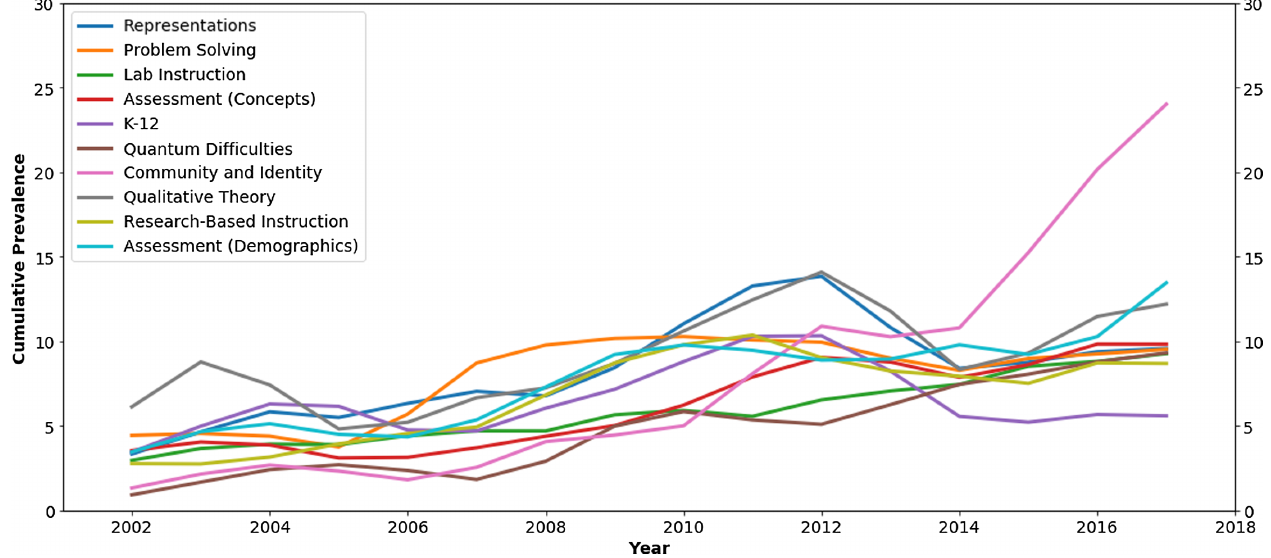
FIG. 8. Cumulative prevalence of topics over time, smoothed using a rolling three-year